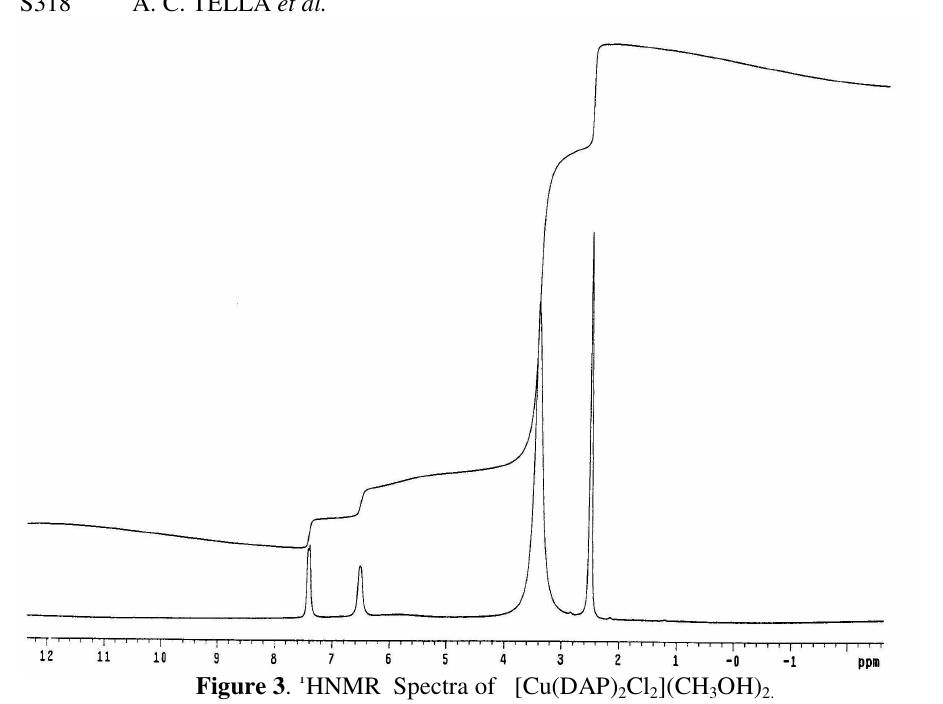
Cl ](CH OH) 2 2 3 2.